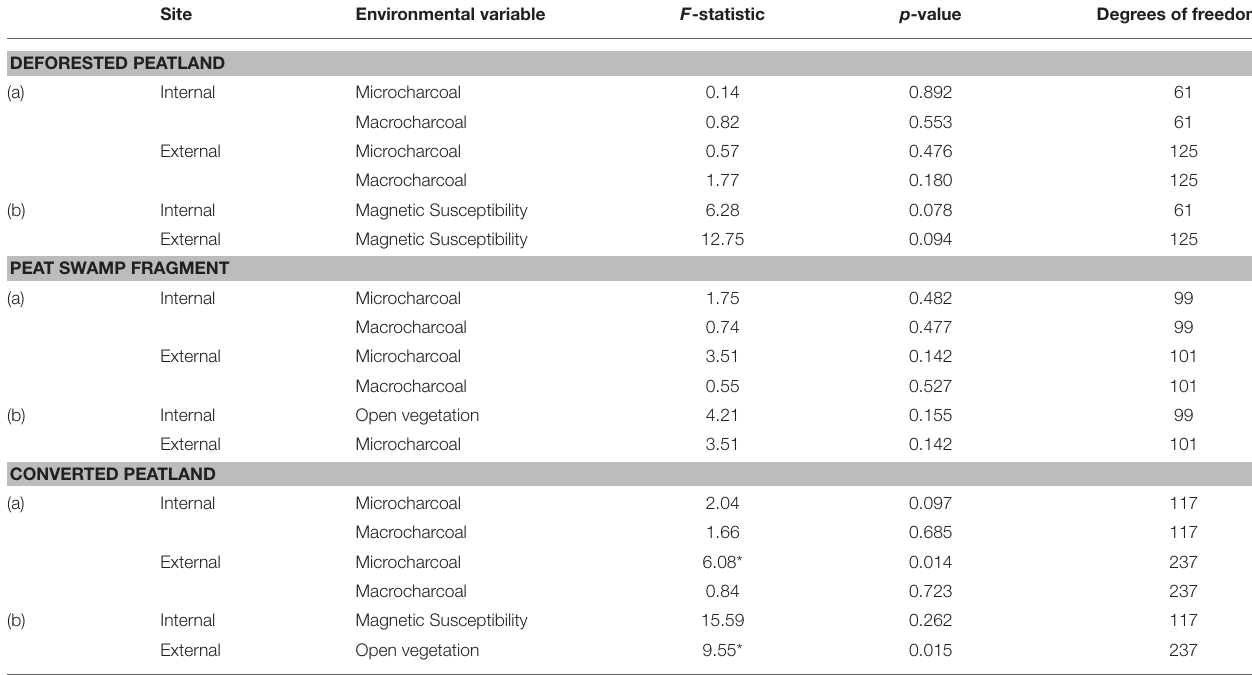
TABLE 1 | Monte Carlo Permutation Test results, performed to analyse the strength of the relationship between changes in the vegetation in each site and (a) microcharcoal and macrocharcoal, and (b) all recorded environmental variables, i.e., macrocharcoal, microcharcoal, magnetic susceptibility and open vegetation (only the strongest relationship is